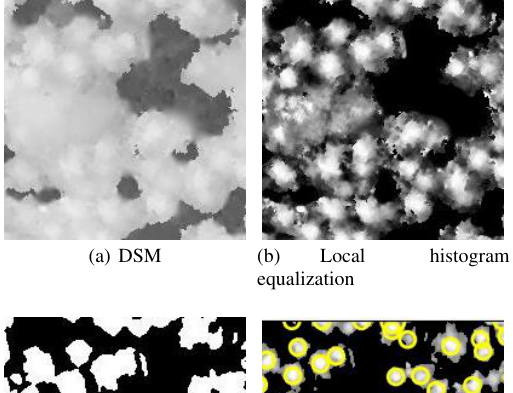
Table 1. Each entry has the form ’segments / detections / omissions / commissions’. The total number of trees for each plot is given in the column header. .